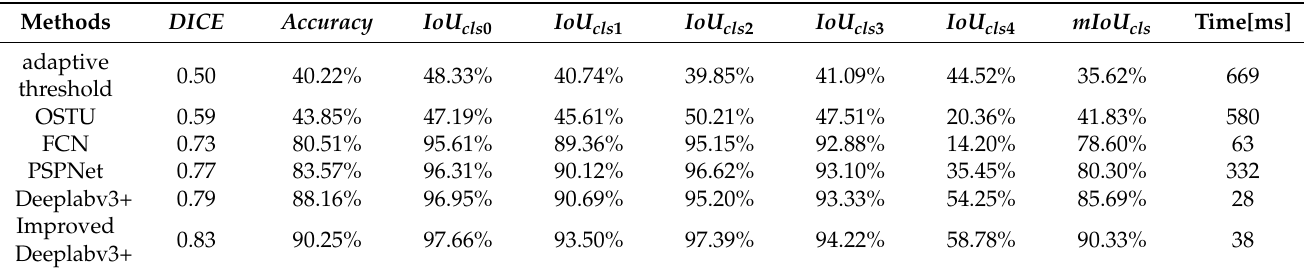
Table 5. Results of six models on SAR